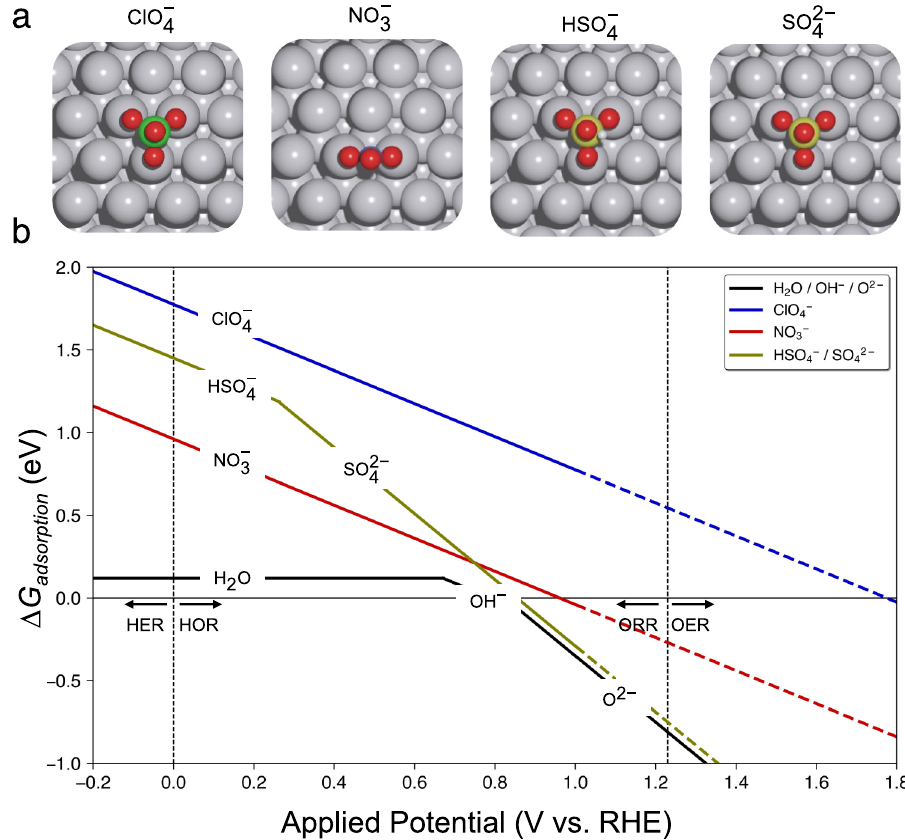
Fig. 3 Potential dependent anion adsorption on Pt(111) surface. a The most stable adsorption con fi gurations of anions on the Pt(111) surface. Color coded: O: red, H: white, Cl: green, N: blue, and S: olive. b The adsorption free energies of the anions, Δ G adsorption (A n − ) (eV), on the Pt(111) surface as a function of applied potential (V vs. RHE). The colored dashed lines qualitatively shows the trends in Δ G adsorption (A n − ) at higher potentials relevant for the oxygen evolution reaction (OER). Since the Pt(111) surface undergoes surface oxidation at these high potentials, we further calculated Δ G adsorption (A n − ) trends on a PtO 2 (110) surface as shown in Supplementary Fig. 5 and Supplementary Table 4. Anion species color-coded: black (H 2 O/OH – /O 2 – ), blue (ClO (cid:1) = SO 2 (cid:1) (NO (cid:1) ), and olive (HSO (cid:1) ). HER/HOR, and ORR stand for hydrogen evolution/oxidation reaction and oxygen reduction reaction, 3 4 4